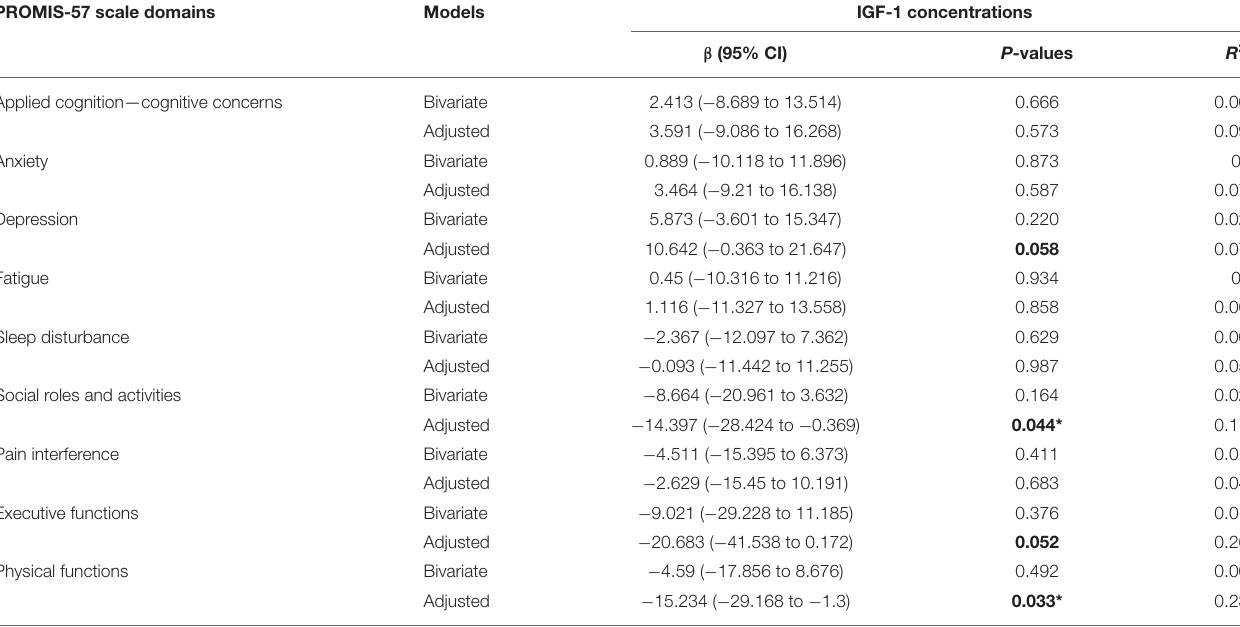
TABLE 3 | Associations between IGF-1 concentrations with patient self-reported measures – PROMIS-57 scale domains.